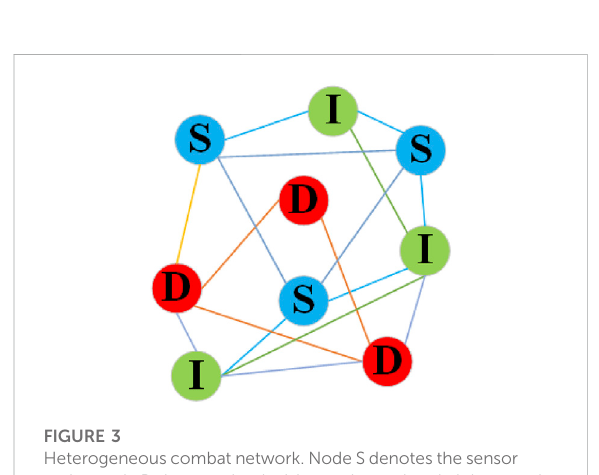
FIGURE 3 Heterogeneous combat network. Node S denotesthe sensor entity, node D denotes the decision entity, and node I denotes the impact